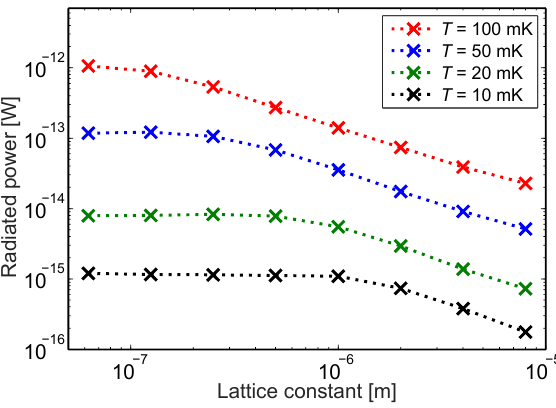
Figure 4. Radiated power for selected temperature points as a function of PnC lattice